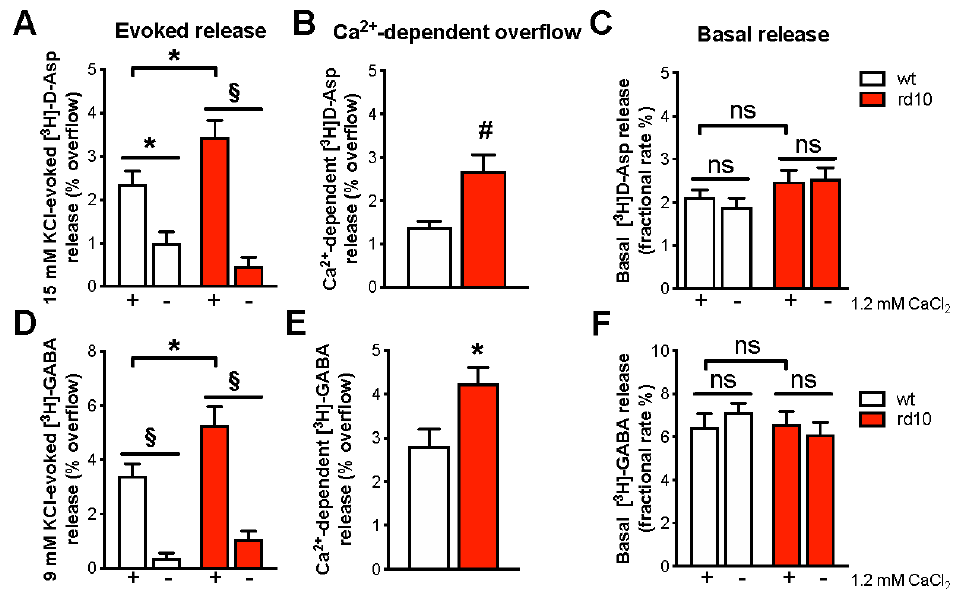
Figure 2. Increased evoked release of glutamate and GABA from synaptosomes of rd10 visual cortex at P60. Synaptosomes were purified from the visual cortex of P60 wt and rd10 mice and incubated in the presence of [ 3 H]D-Asp or [ 3 H]GABA in order to label the intraterminal releasing pools of glutamate and GABA, respectively. KCl (15 mM for glutamate experiments and 9 mM for GABA experiments) was introduced after 39 min of superfusion. When appropriate, Ca 2+ was omitted 19 min before KCl (the + symbol below the x axis refers to Ca 2+ -dependent release, the − sign indicates Ca 2+ -free release). Then, samples were counted for radioactivity. Basal release results are expressed as fractional rate percent, while evoked release and Ca 2+ -dependent overflow results are expressed as percent overflow released by high KCl. Data are expressed as mean ± s.e.m. of 4–9